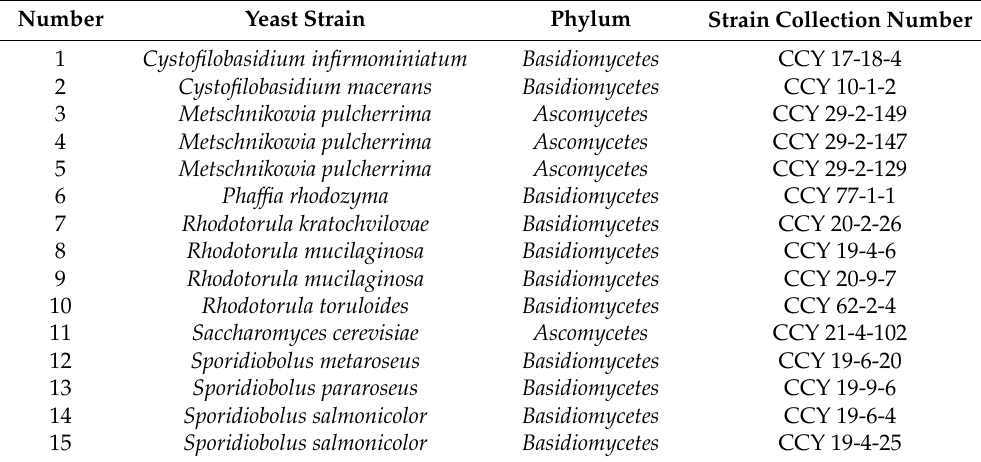
Table 1. List of the yeast strains used in this